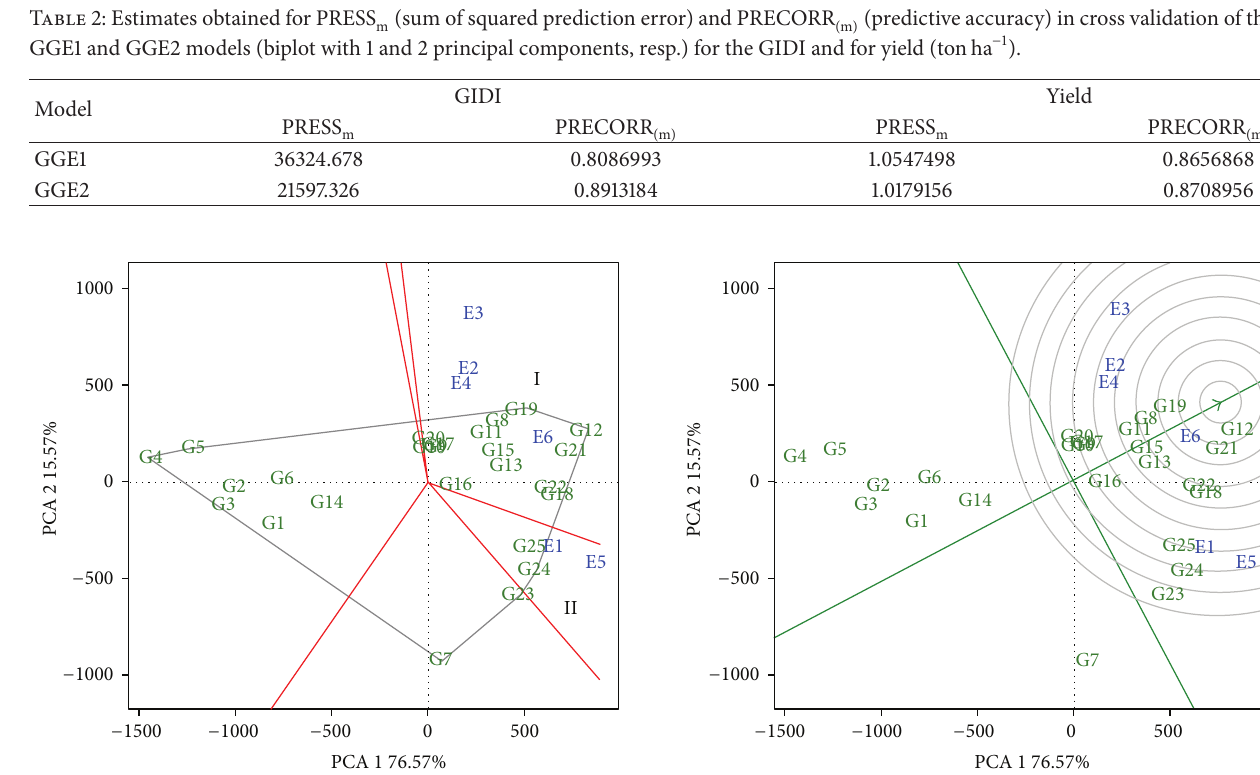
(predictive accuracy) in cross validation of the (m)